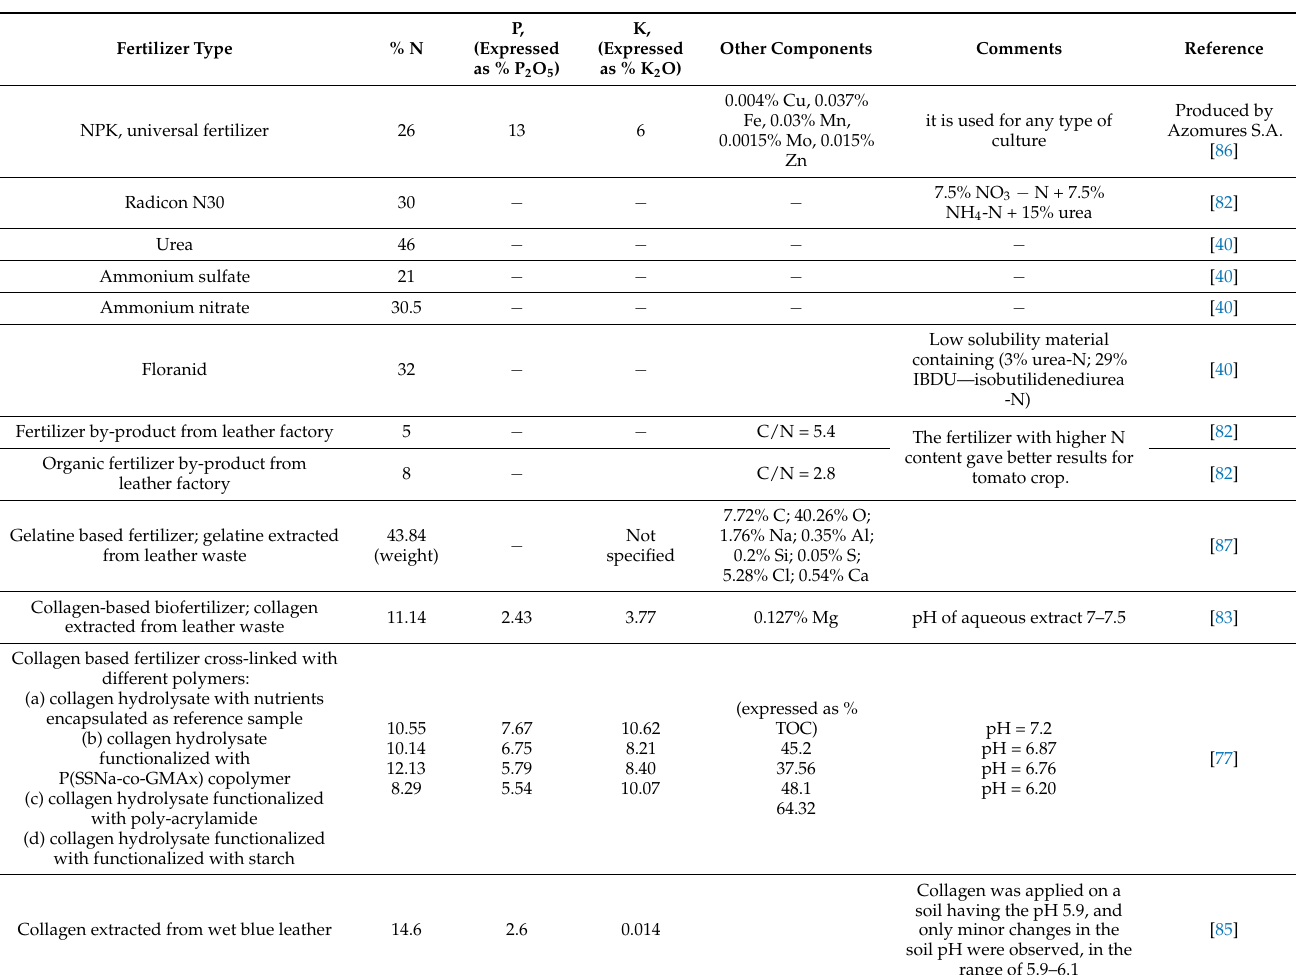
Table 2. Composition of different biopolymer-based fertilizers obtained from leather